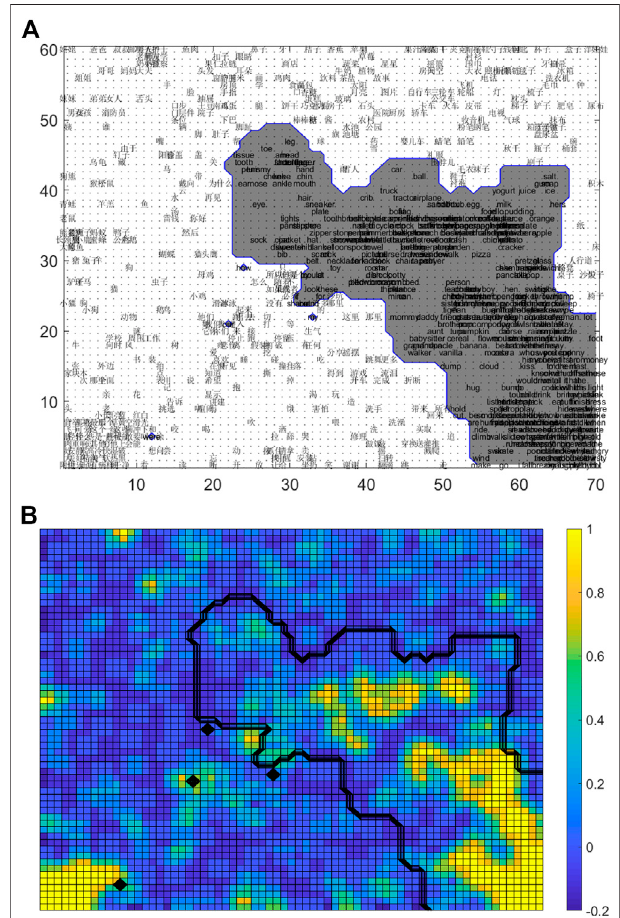
FIGURE 3 | Bilingual lexical-semantic representations of early L2 learning in the DevLex-II model. Circled areas correspond to L2 (English) words.Top: (A) Semanticmap;Bottom (B) Heatmapwithdensitymeasureof each node, brighter color indicates higher density level.